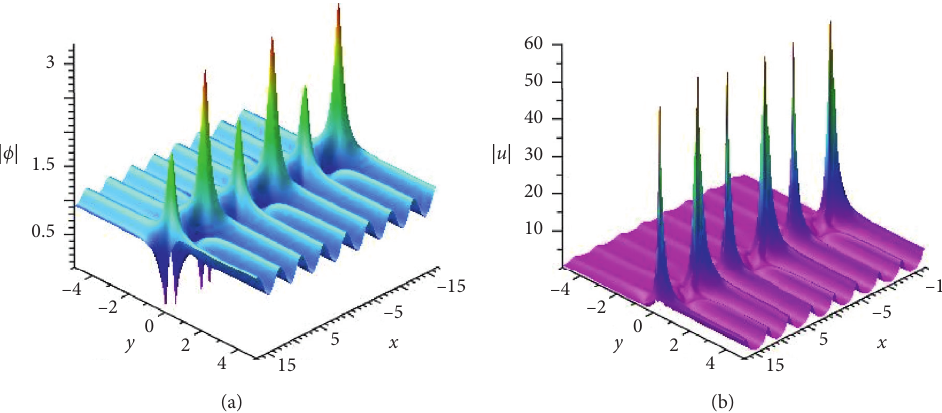
Figure 3: The mixed solutions | ϕ | and | u | consisting of one breather and periodic line waves in the nonlocal Mel ′ nikov equation given by equation (18) with parameters κ � 1 ,P